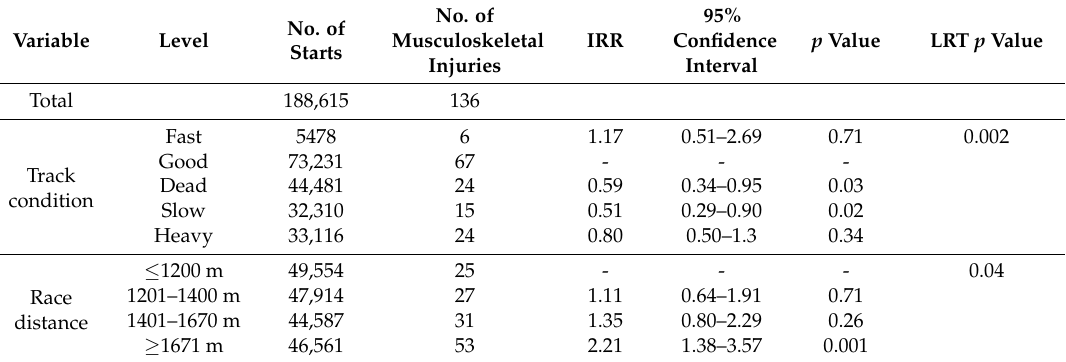
Table 3. Results of multivariable Poisson regression model of the variables significantly associated with musculoskeletal injury occurring during Thoroughbred flat races in New Zealand (2005–2011) ( n = 136) a